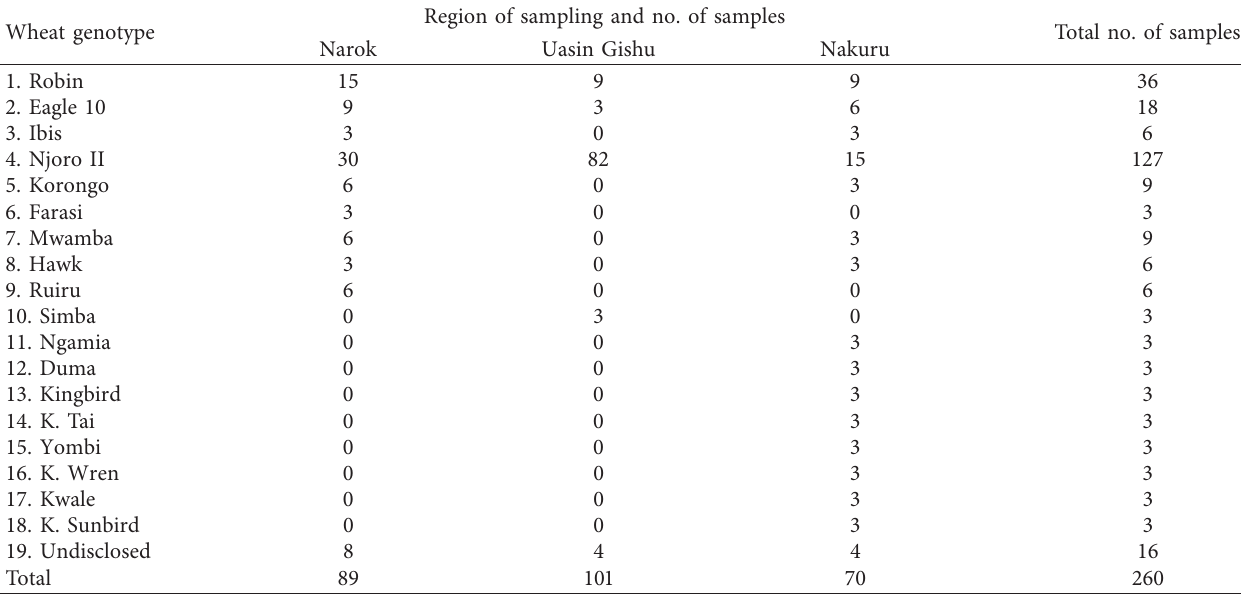
Table 1: Wheat genotypes sampled in three Rift Valley regions, Kenya. Region of sampling and no. of Wheat genotype